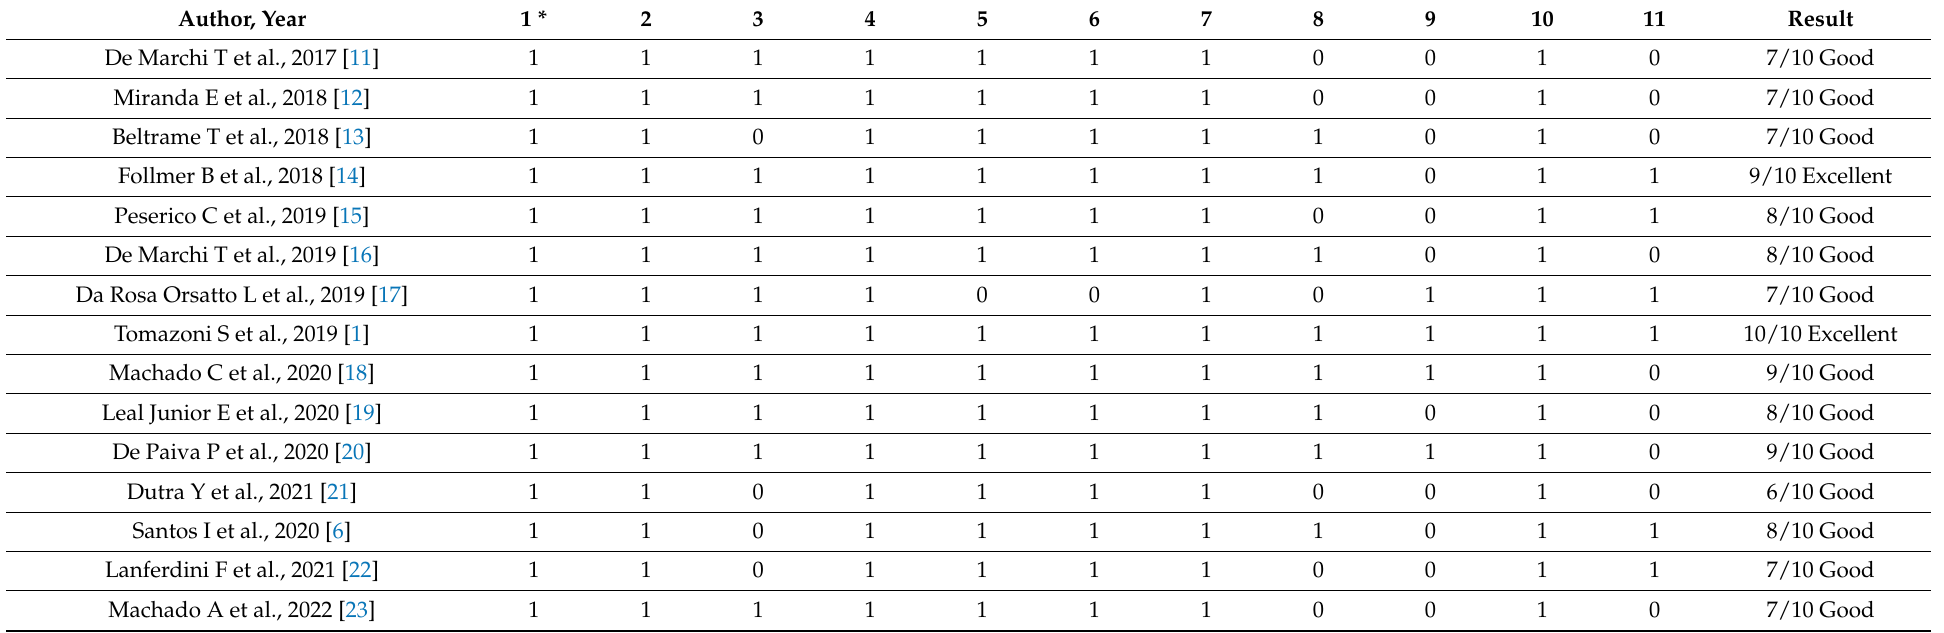
Table 2. The RCTs’ quality assessed methodologically using the PEDro